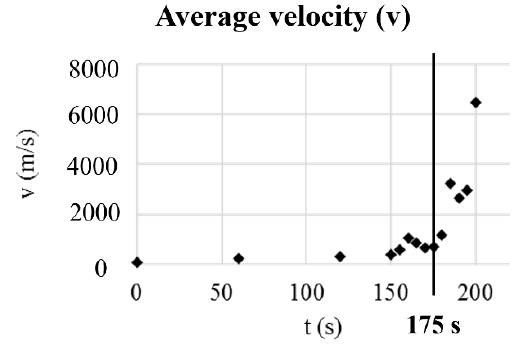
Figure 14. Average velocity of grinding stones in the top layer.